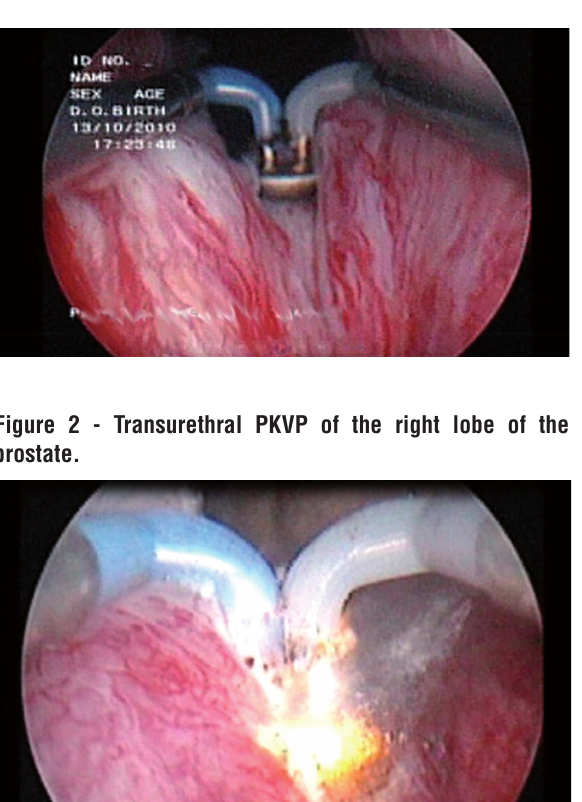
Figure 1 - Initiation of the transurethral PKVP.